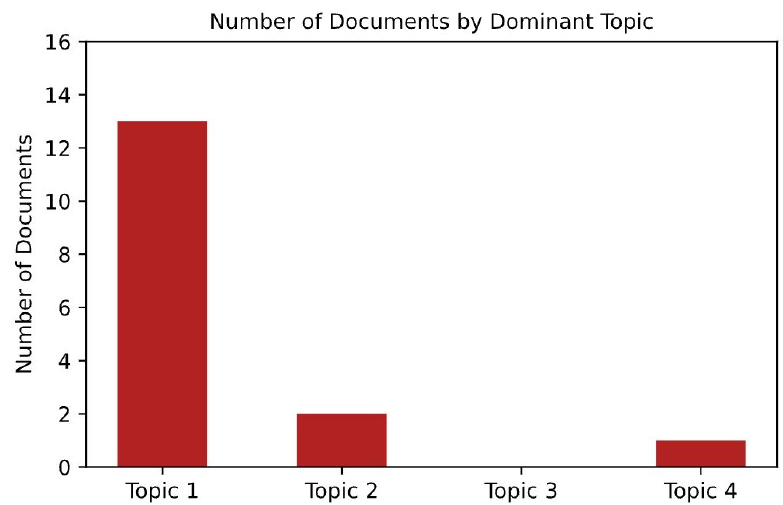
Figure 9. Distribution of discovered topics in the documents from the dataset (introduced in Section